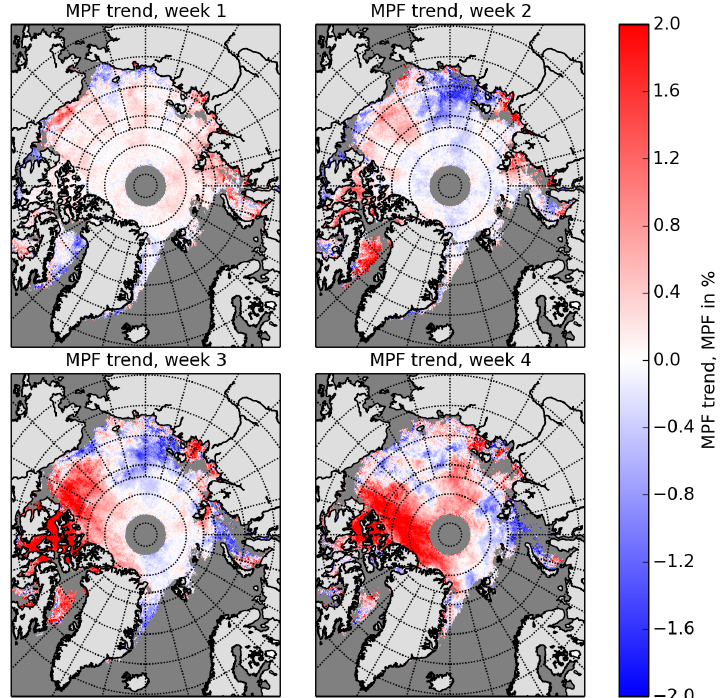
Figure 7. Melt pond fraction trends (trend in MPF %) for the 4 weeks of June for the whole investigation period 2002–2011.